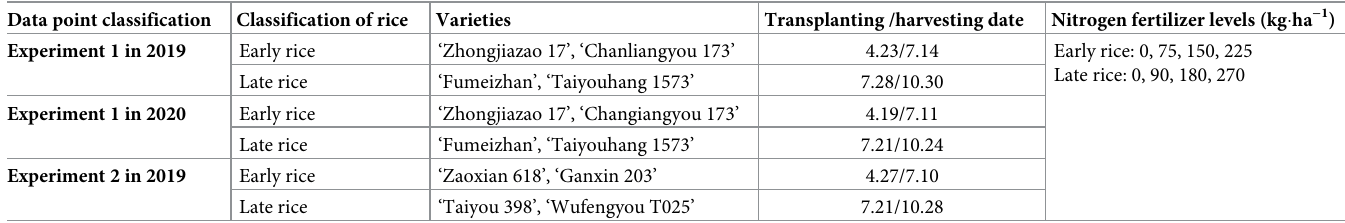
Table 1. Basic information on the two